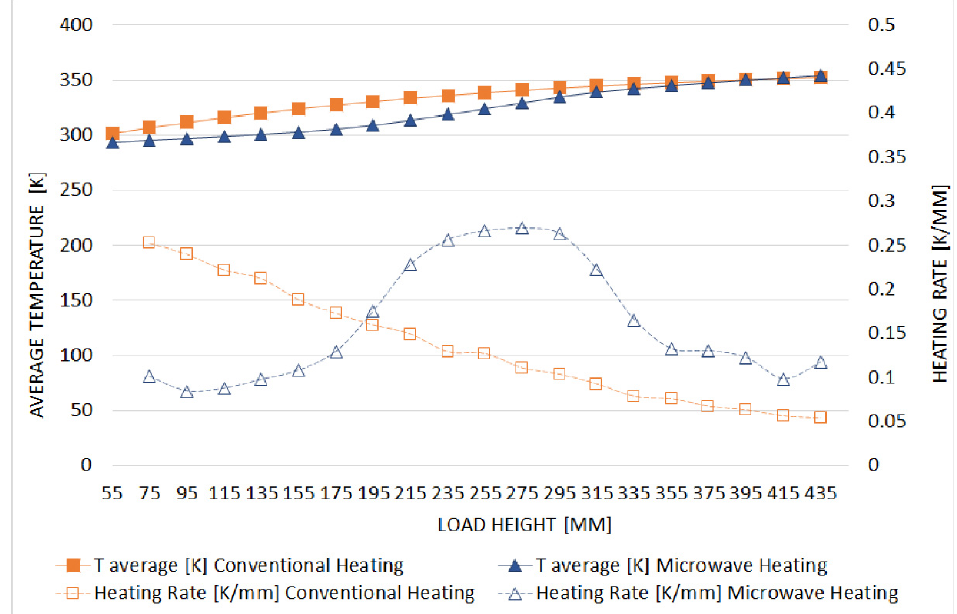
Figure 6. Average temperatures and heating rates (dotted lines) of the load along the applicator height in the front of the helix with respect to the waveguide, in the case of conventional and microwave heating.